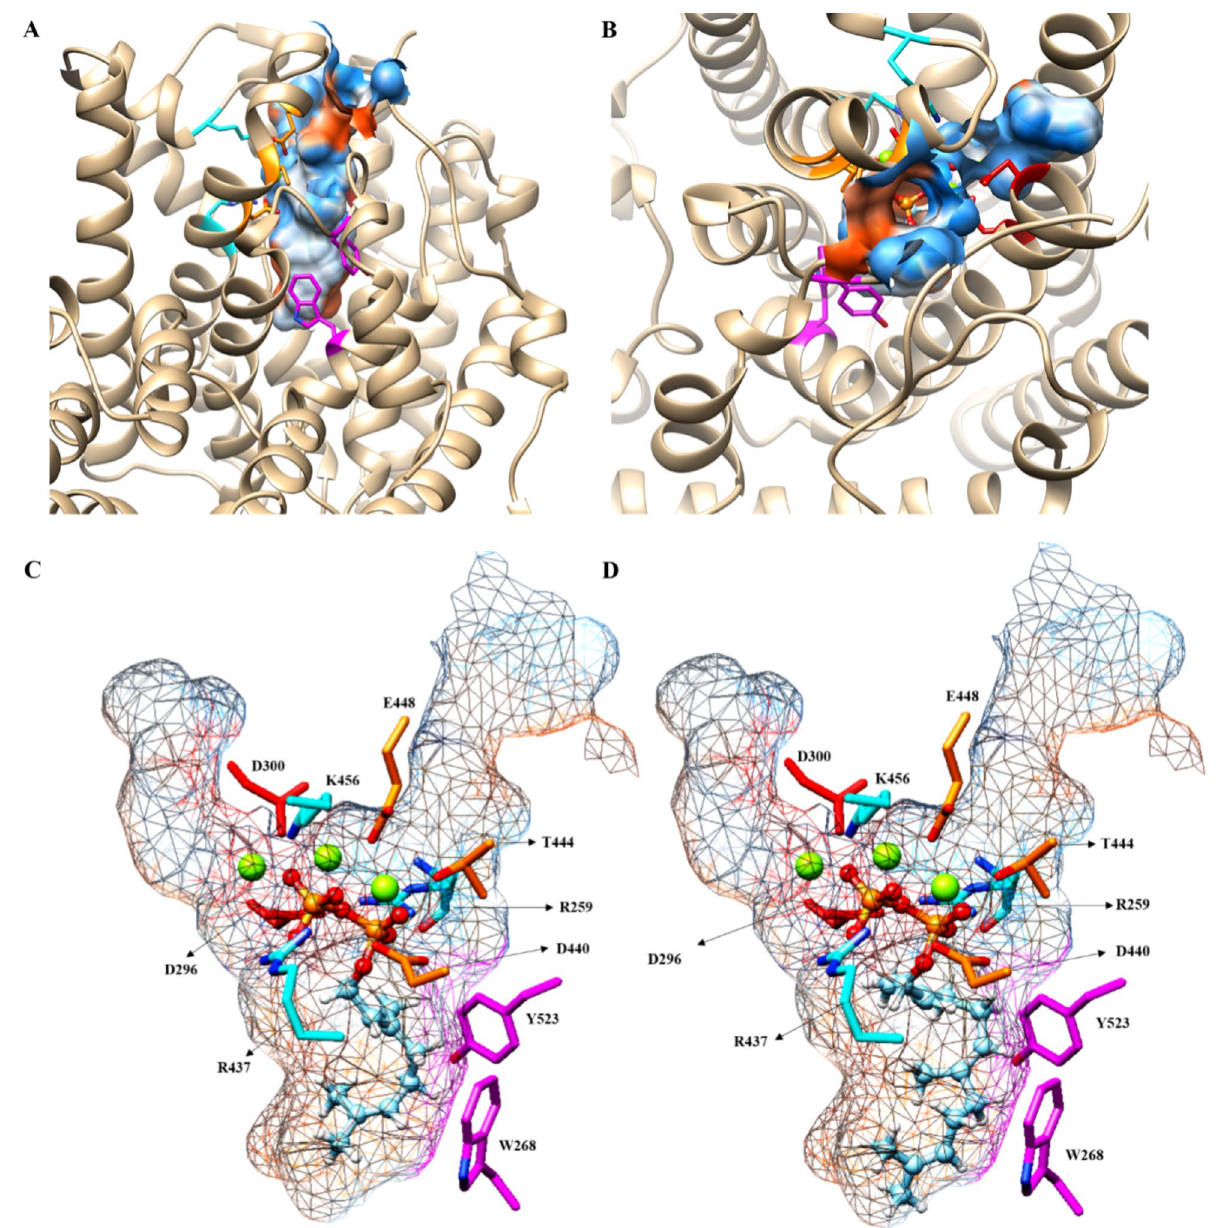
Figure 5. The Pam Tps1 active site pocket. The overview of Pam Tps1 active site pocket from ( A ) top and ( B ) side views. Docking positions of ( C ) GPP and ( D ) FPP in Pam Tps1 active site cavity. The Pam Tps1 active site is a deep hydrophobic pocket consisting of C, D, F, G, H and J helices. The red–orange ball and stick chains represent the PPi of substrate, green spheres are the Mg 2+ , the orange side chains are the DTE motifs, the blue side chains are the hydrogen bond donor residues and the magenta side chains represent the aromatic